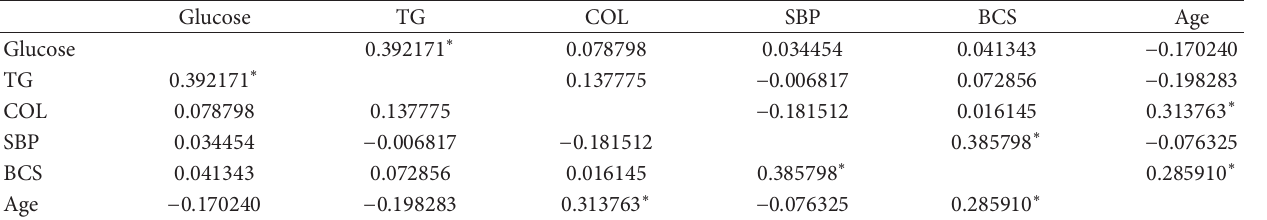
Table 2: Spearman rank order correlations pairwise matrix from 62 dogs with two or more inclusion criteria for MS. Glucose TG COL SBP BCS Age Glucose 0.392171 ∗